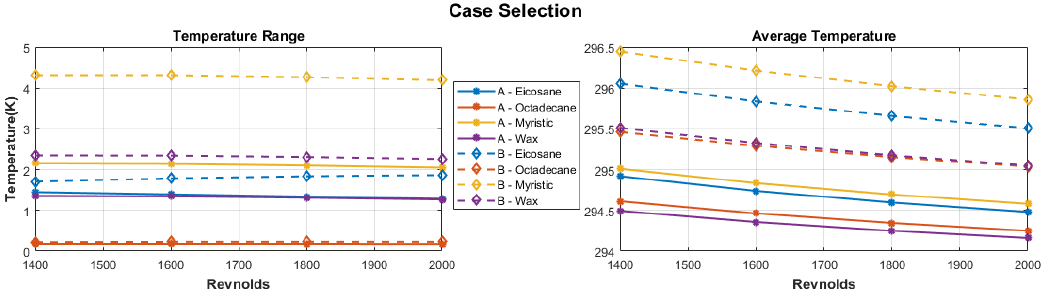
Figure 4. Cold outlet temperature fluctuation range and average temperature at various Reynolds numbers for different PCMs in Case A (hot inner) and Case B (cold inner)